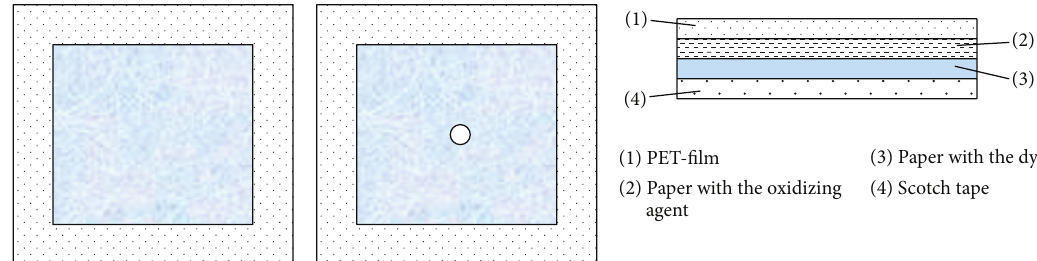
Figure 3: Test tool for kinetic determination of Co(II) based on double-layer paper “sandwich.”